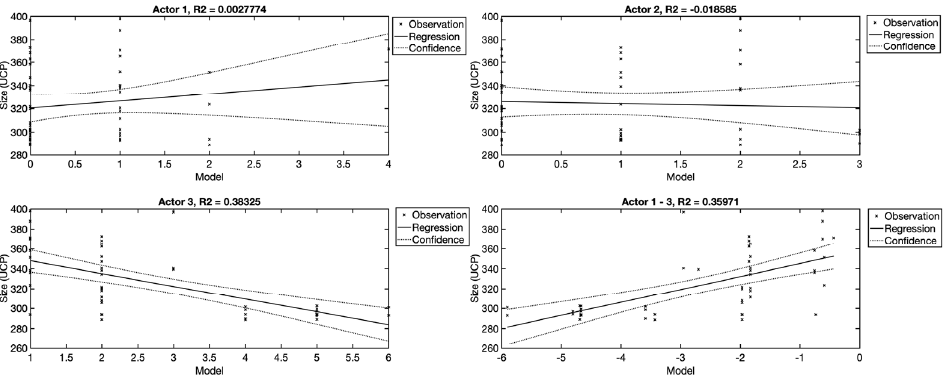
Figure 7. Comparison of regression models for individual types of actors.